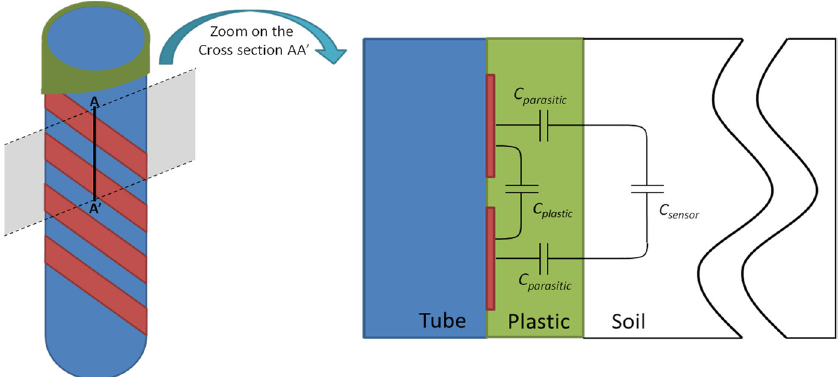
Figure 18. Coating protection parasitic effect.